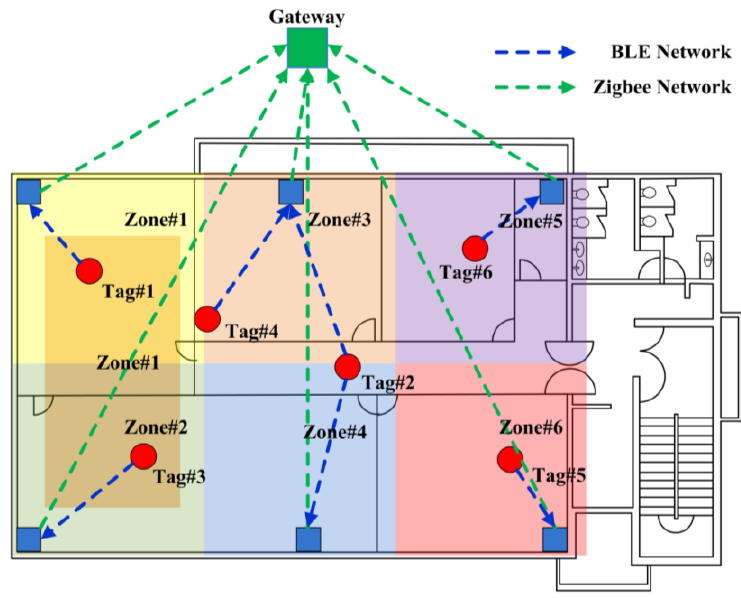
Figure 2. Configuration of network in a building construction project.